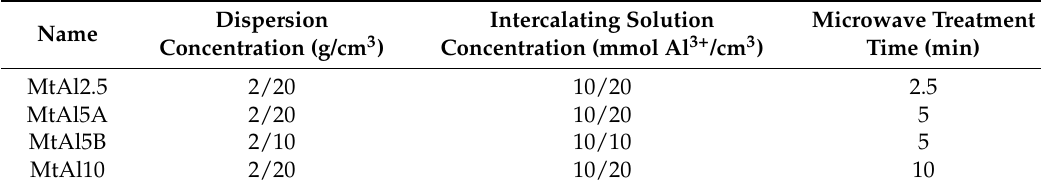
Table 1. Nomenclature of the solids and preparation